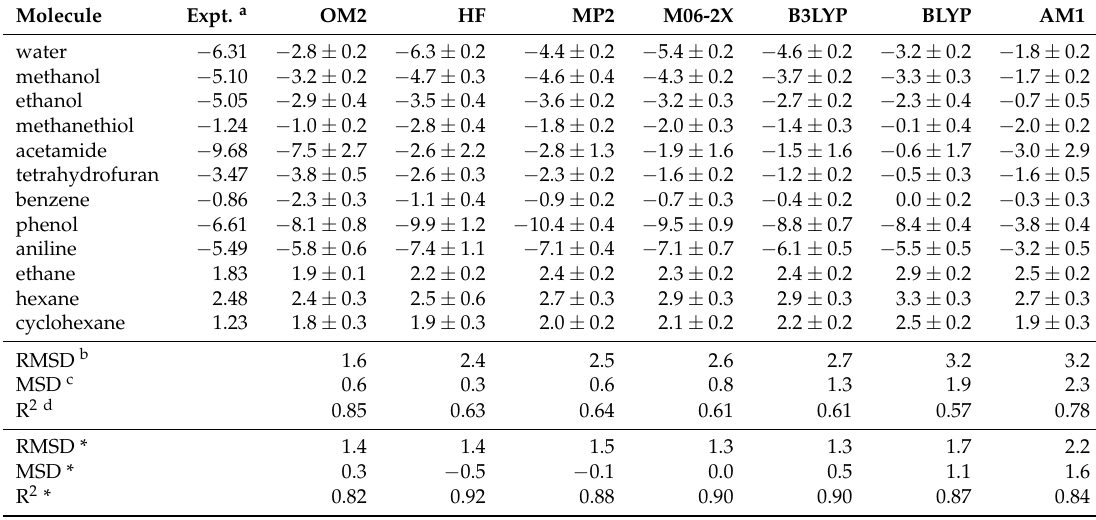
Table 3. Hydration free energies of QM/MM with different QM methods based on trajectories of the CHARMM Drude force